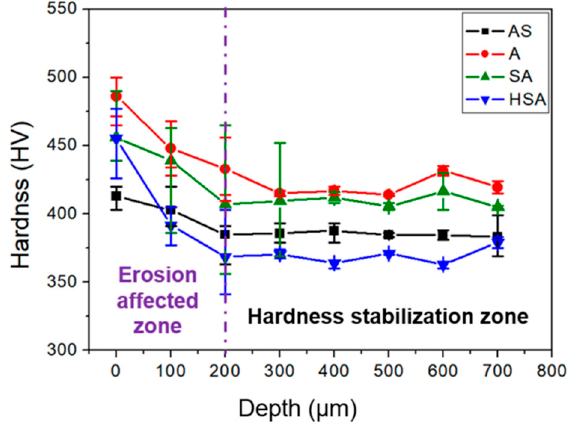
Figure 12. Microhardness distribution of ASE, AE, SAE, and HSAE in the longitudinal direction.